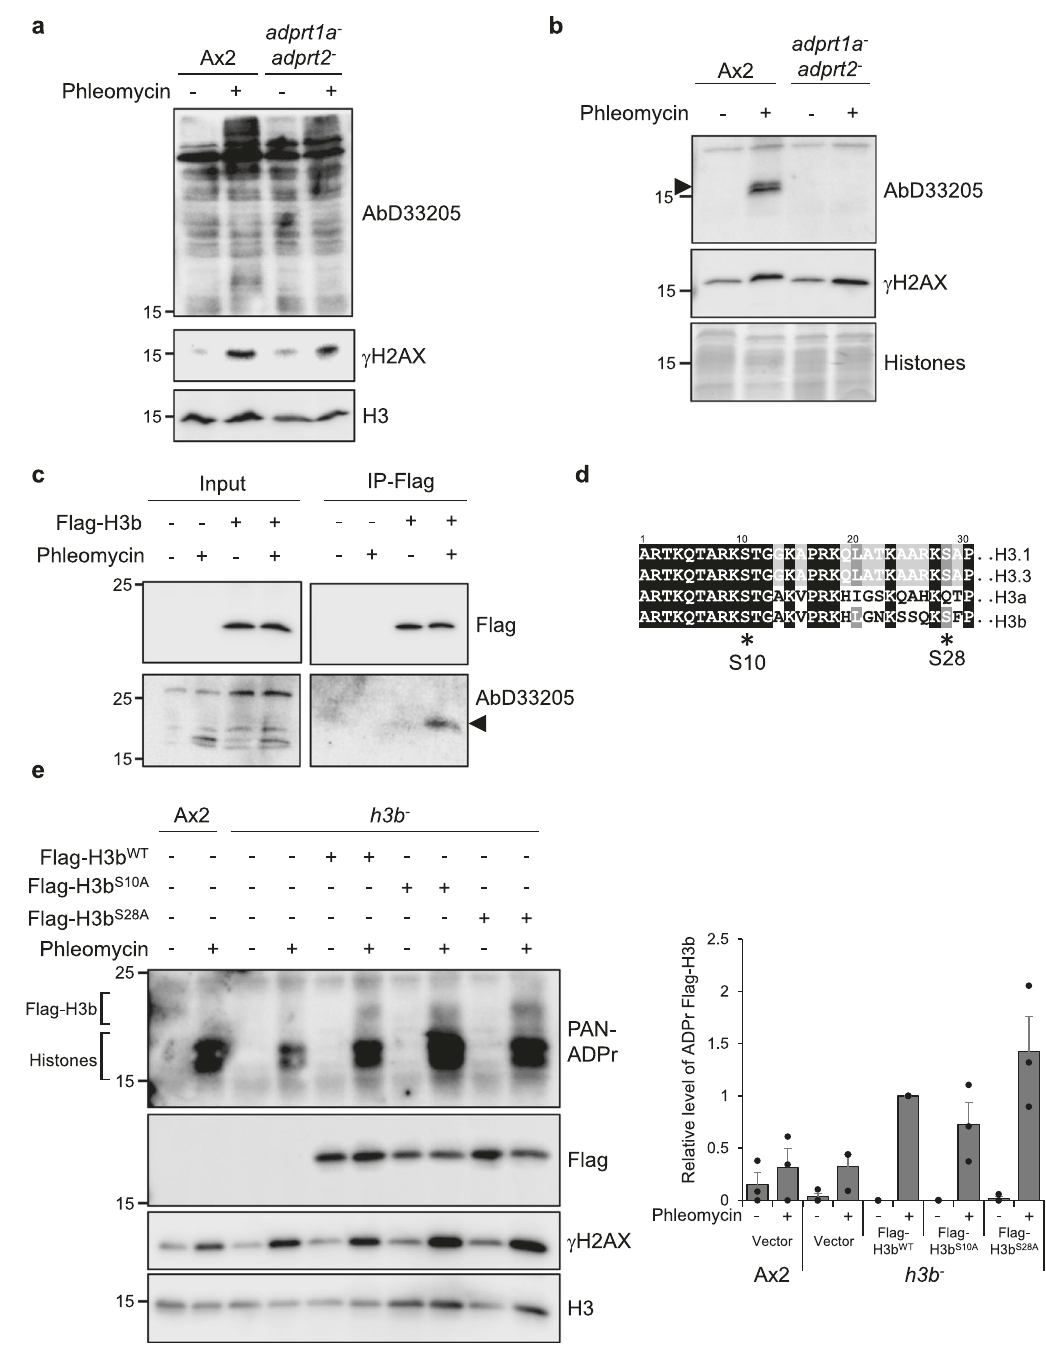
Fig. 2 H3b is ADP ribosylated on serine in response to DNA damage. a , b Ax2 or adprt1a − adprt2 − cells were treated with phleomycin and whole cell (a) or acid ( b ) extracts western blotted with antibodies as indicated. Molecular weight markers are indicated in kDa. Representative pictures of three biological repeats are presented. c h3b − cells containing empty vector, or expressing Flag-H3b wt , were left untreated or exposed to phleomycin. Following preparation of denatured chromatin, Flag immunoprecipitation was performed. Input extracts or immunoprecipitates were subjected to Western blotting using the indicated antibodies. Molecular weight markers are indicated in kDa. Representative pictures of at least three independent experiments. d Sequence comparison of human histone H3.1 and H3.3 with the Dictyostelium H3 variants H3a and H3b. S10 and S28, the main ADP-ribosylation targets in vertebrates are indicated. e Ax2 or h3b − cells containing empty vector, or expressing Flag-H3b WT , Flag-H3b S10A or Flag-H3b S28A were left untreated or exposed to phleomycin. Following preparation of acid extracts, western blotting was performed using the indicated antibodies. ADP-ribosylated endogenous histones and Flag-H3b are highlighted. Enrichment of Flag-H3b in chromatin fractions was quanti fi ed (right panel; n = 3; individual data points are shown and error bars represent the SEM). Molecular weight markers are indicated in kDa. Source data are provided in the Source Data fi